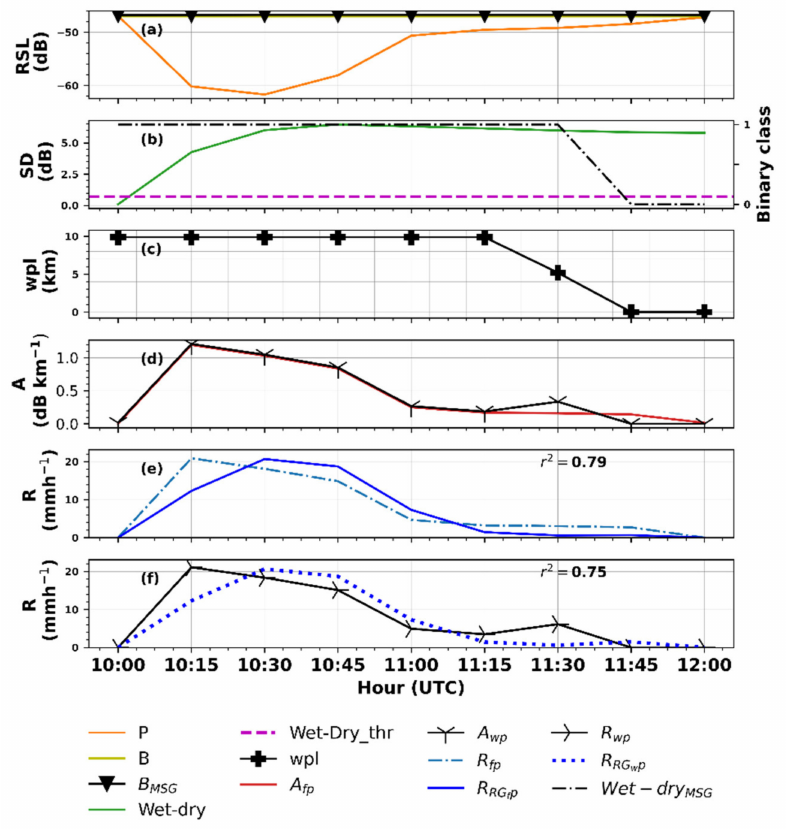
Figure 3. From MWL mean RSL to rainfall for 15 min interval rain events of 8 May 2018. ( a ) compares the conventional ( B ) and MSG technique ( B MSG ) baseline level to the mean RSL ( P ), ( b ) compares wet–dry classification by the conventional (wet–dry) and MSG technique (wet–dry MSG )—the stan- dard deviation threshold (wet–dry_thr, dashed pink line) value (0.7 dB) separates the wet and dry periods in the conventional technique; a binary class showing raining (1) and non-raining (0) peri- ods separates the wet and dry periods in the MSG technique—( c ) is the wpl over which the MSG technique computed attenuation ( A wp ), ( d ) compares the conventional ( A fp ) and MSG technique ( A wp ) attenuation, ( e ) compares the conventional MWL rainfall intensity ( R fp ) and the actual mean rainfall intensity ( R RGfp ), and ( f ) compares the MSG technique MWL rainfall intensity ( R wp ) and actual mean rainfall intensity ( R RGwp